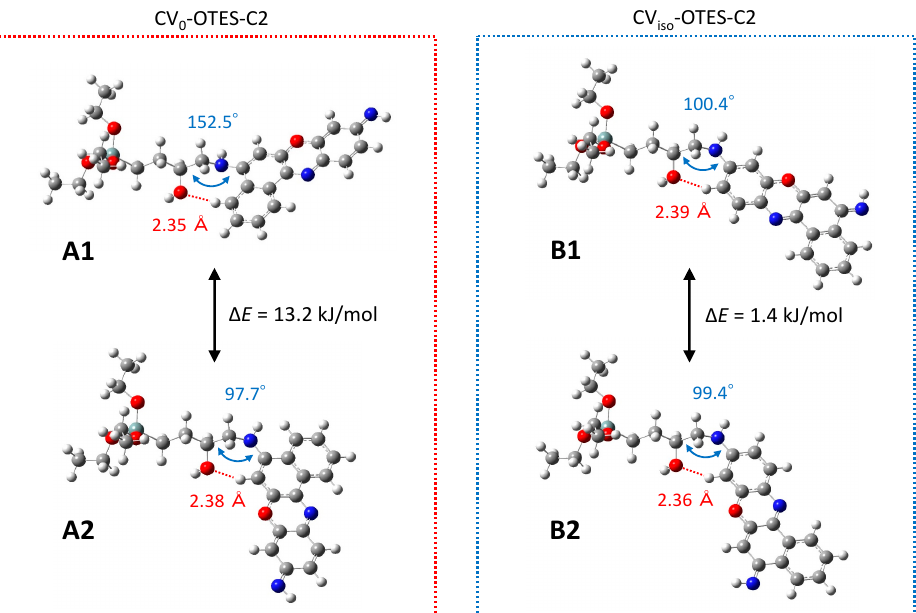
Figure 3. Optimized structures of CV 0 –OTES–C2 and CV iso –OTES–C2 in the gas phase, calculated at the B3LYP / 6-31G* level of theory. The geometries of CV 0 –OTES–C2 and CV iso –OTES–C2 are labeled as A1 and A2 and B1 and B2, respectively. The distance of the CH–O interaction, C–C–N–C dihedral angle and energy difference ( Δ E ) are shown in red, blue and black, respectively (see the text for further details).